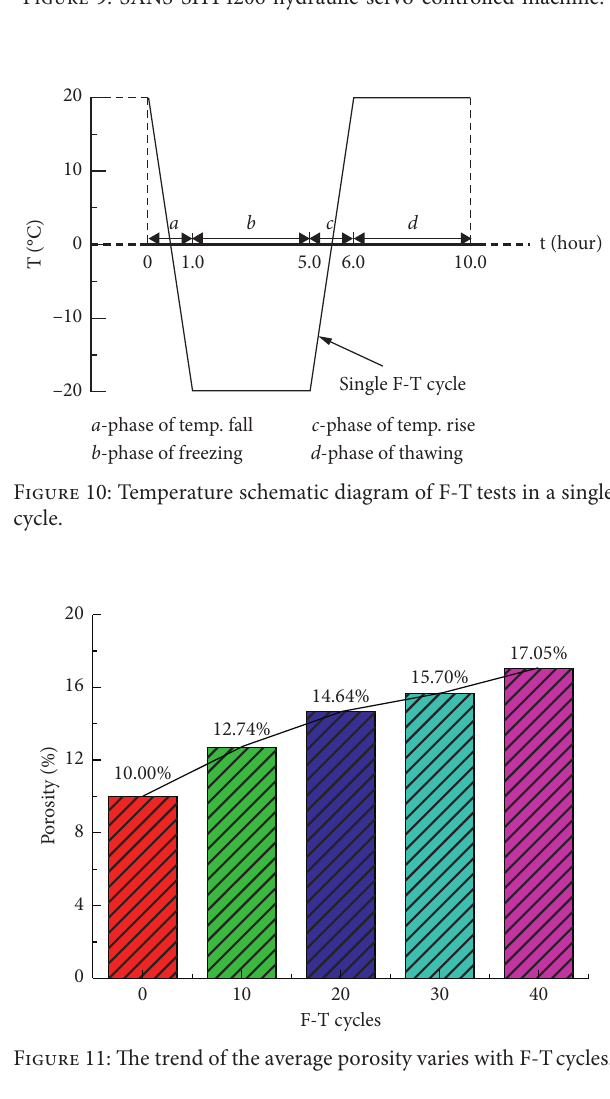
Figure 9: SANS-SHT4206 hydraulic servo-controlled machine.